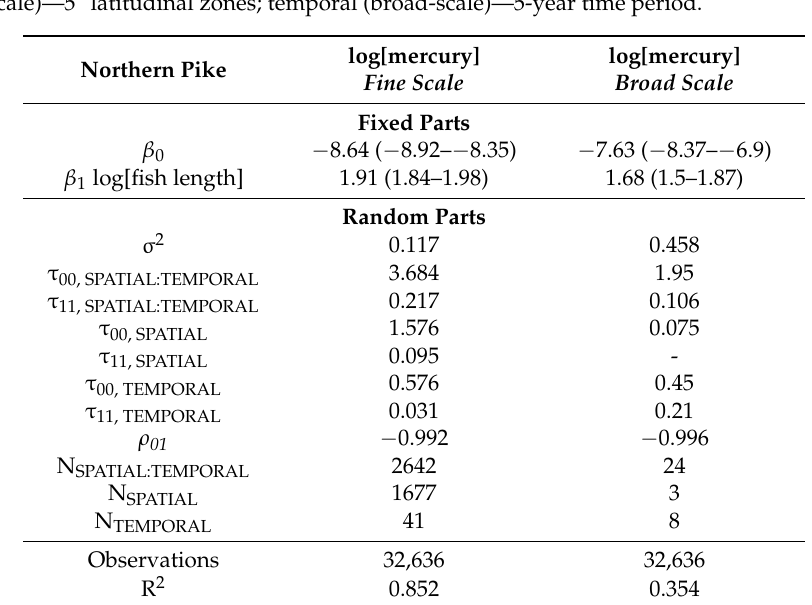
Table 4. Summary of the best-fitting LMEM for Northern Pike at fine and broad scale of analysis. The subscripts ‘spatial’ and ‘temporal’ associated with the random parts are different for the fine and broad scale of analysis: spatial (fine-scale)—waterbodies; temporal (fine-scale)—year; spatial (broad-scale)—5 ◦ latitudinal zones; temporal (broad-scale)—5-year time